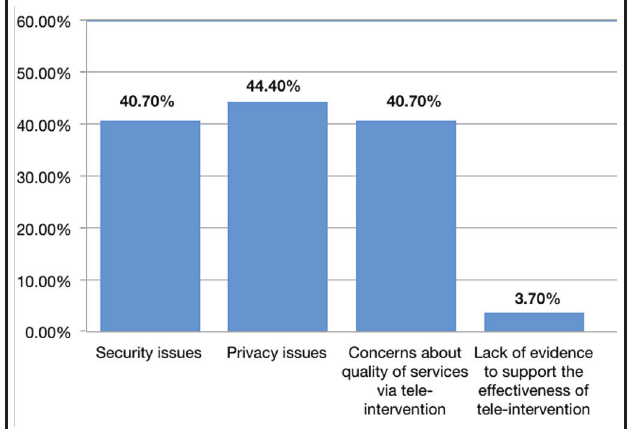
Table 3: Expressed barriers and concerns associated with a telehealth service delivery